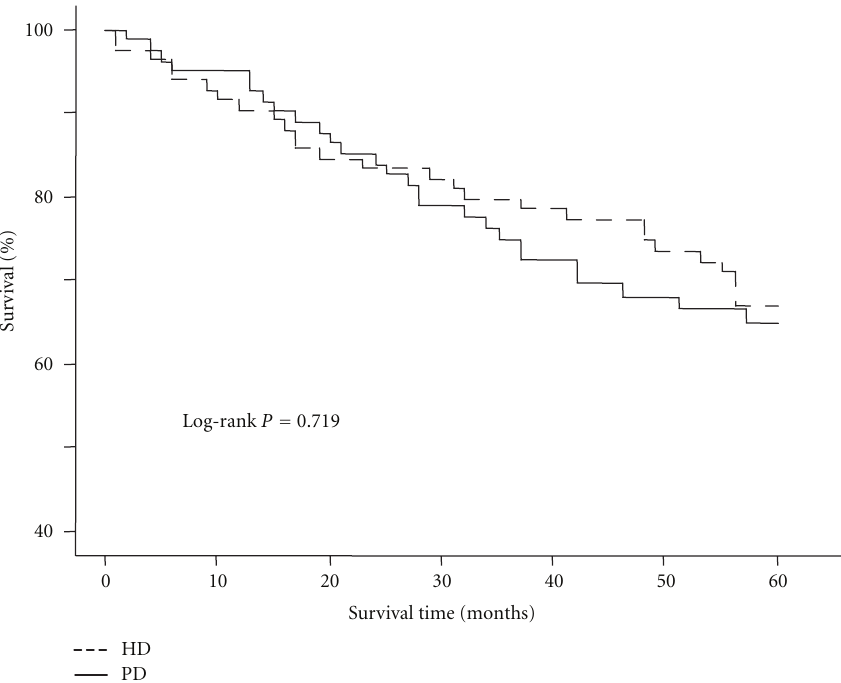
Figure 1: Kaplan-Meier survival curves by dialysis modality. PD: peritoneal dialysis; HD: